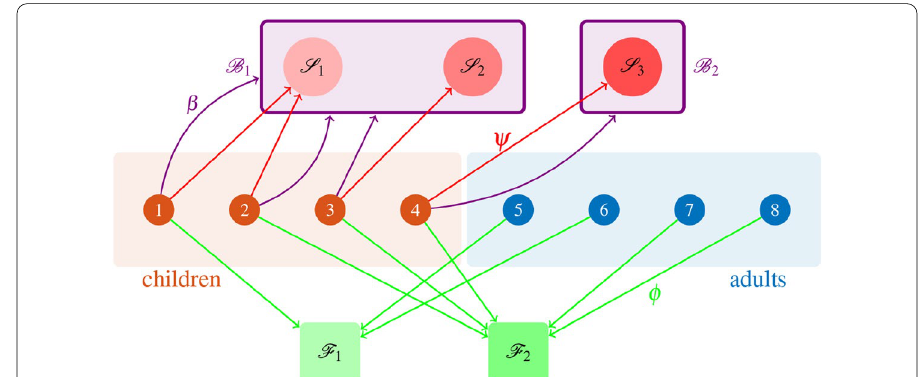
Fig. 1 Schematic of the population structure. In this simple example, four children C = { 1,2,3,4 } and four adults A = { 5,6,7,8 } are partitioned into three school classes (red circles above), placed into two different buildings (violet rectangles), and two families (green squares below), by means of the functions ψ and